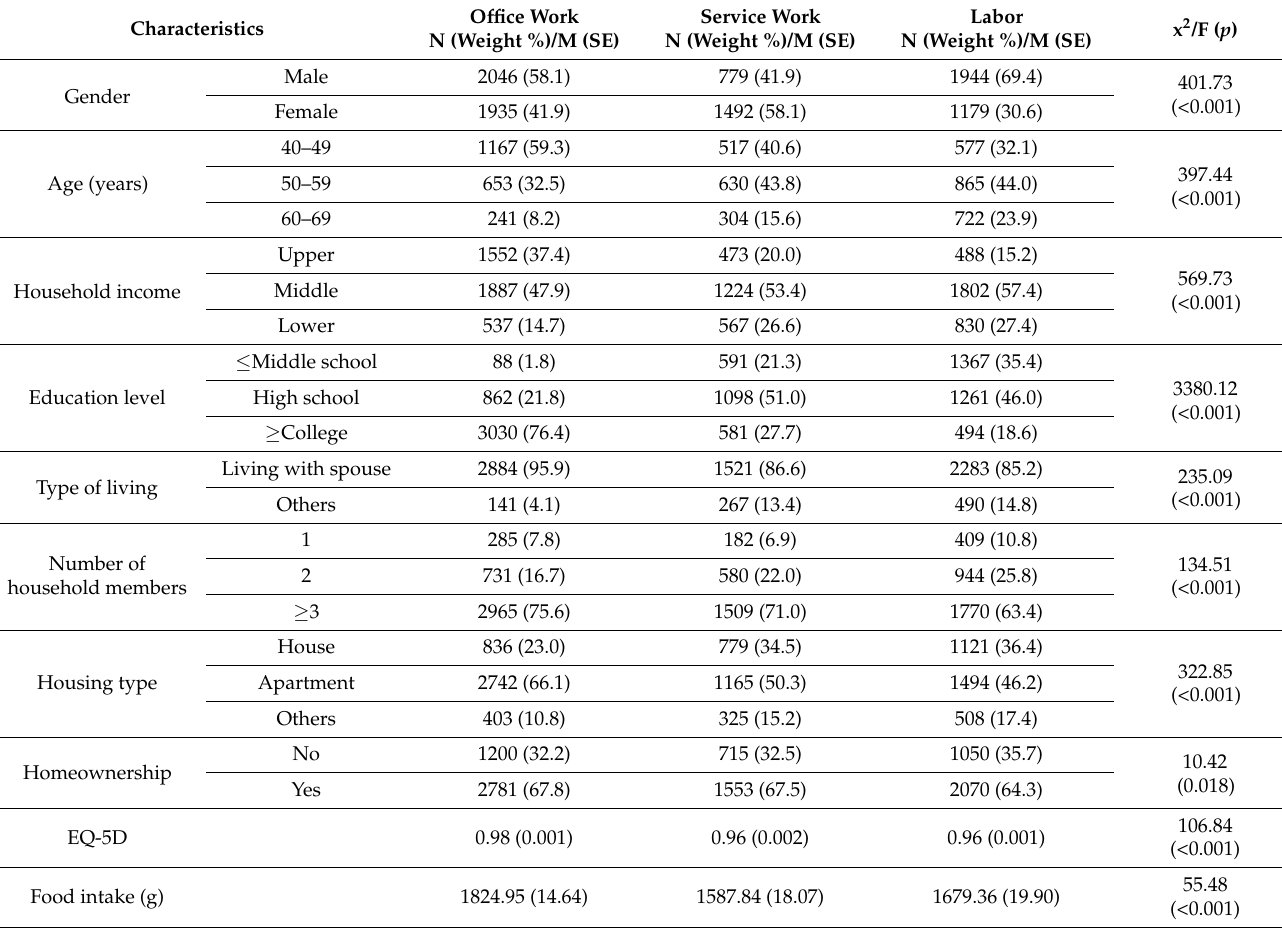
Table 1. Participant sociodemographic characteristics (N =